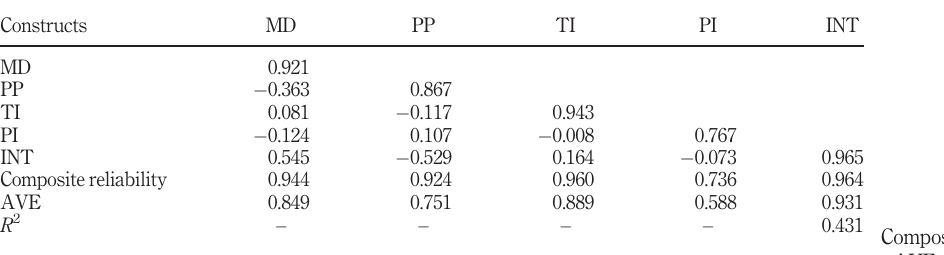
Table 1. Composite